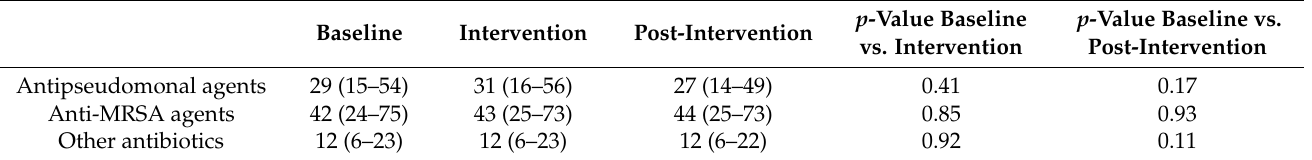
Figure 1. Trends in the clinical outcomes before and after the interventions. Error bars represent 95% confidence intervals. ( a ) Incidence of HA-CDI per 10,000 patient-days. HA-CDI, hospital-acquired Clostridioides difficile infection. ( b ) 30-day mortality due to bacteremia. Table 8 shows the length of hospital stay of patients undergoing antibiotic treatment. Table 8. Length of hospital stay by patients who received antibiotics, median days (IQR). The monthly median and mean data are presented in Supplemental Tables S7 and S8, respectively. Among patients who received different classes of antibiotics, no significant p -Value Baseline p -Value Baseline vs. difference in the length of hospitalization stay during the study period was observed. Baseline Intervention Post-Intervention vs. Intervention